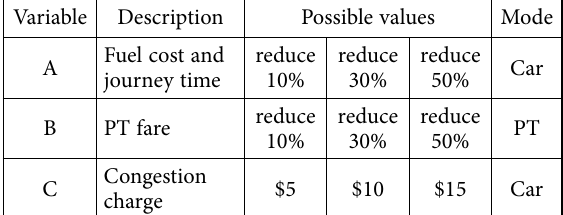
Table 2. Variables and values for the SP